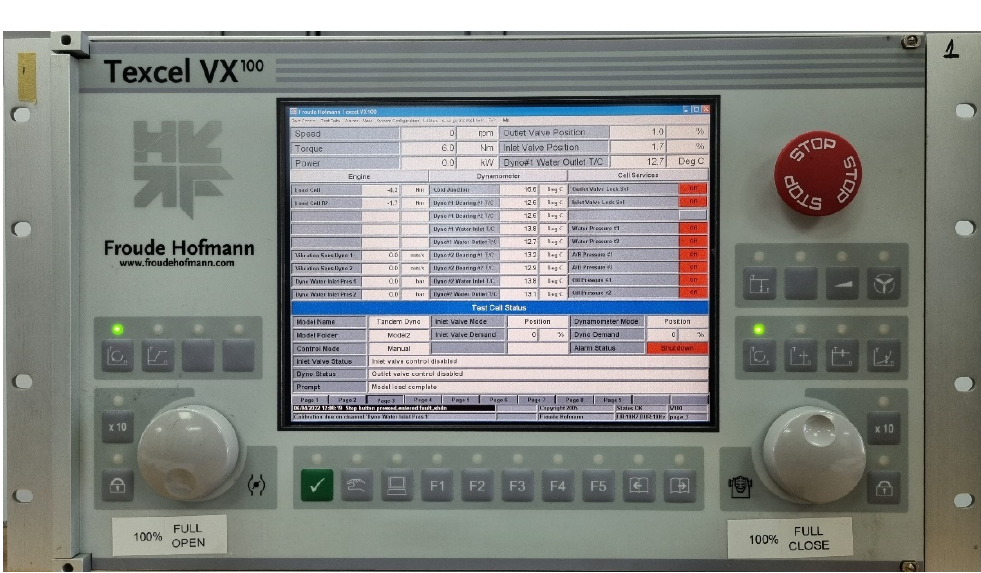
Figure 6. Engine fuel control and engine operation law scheme.